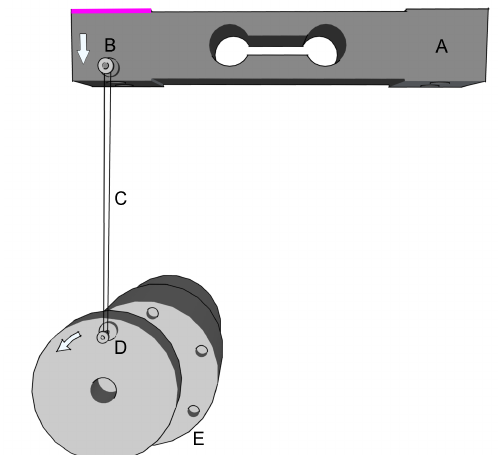
Figure 4. Experimental setup for Rehapiano validation. The direction of rotation of the DC motor and the force applied to the strain gauge are indicated by arrows. (A: fixed, B: force applied, C: elastic band, D: pulley, E: DC motor).